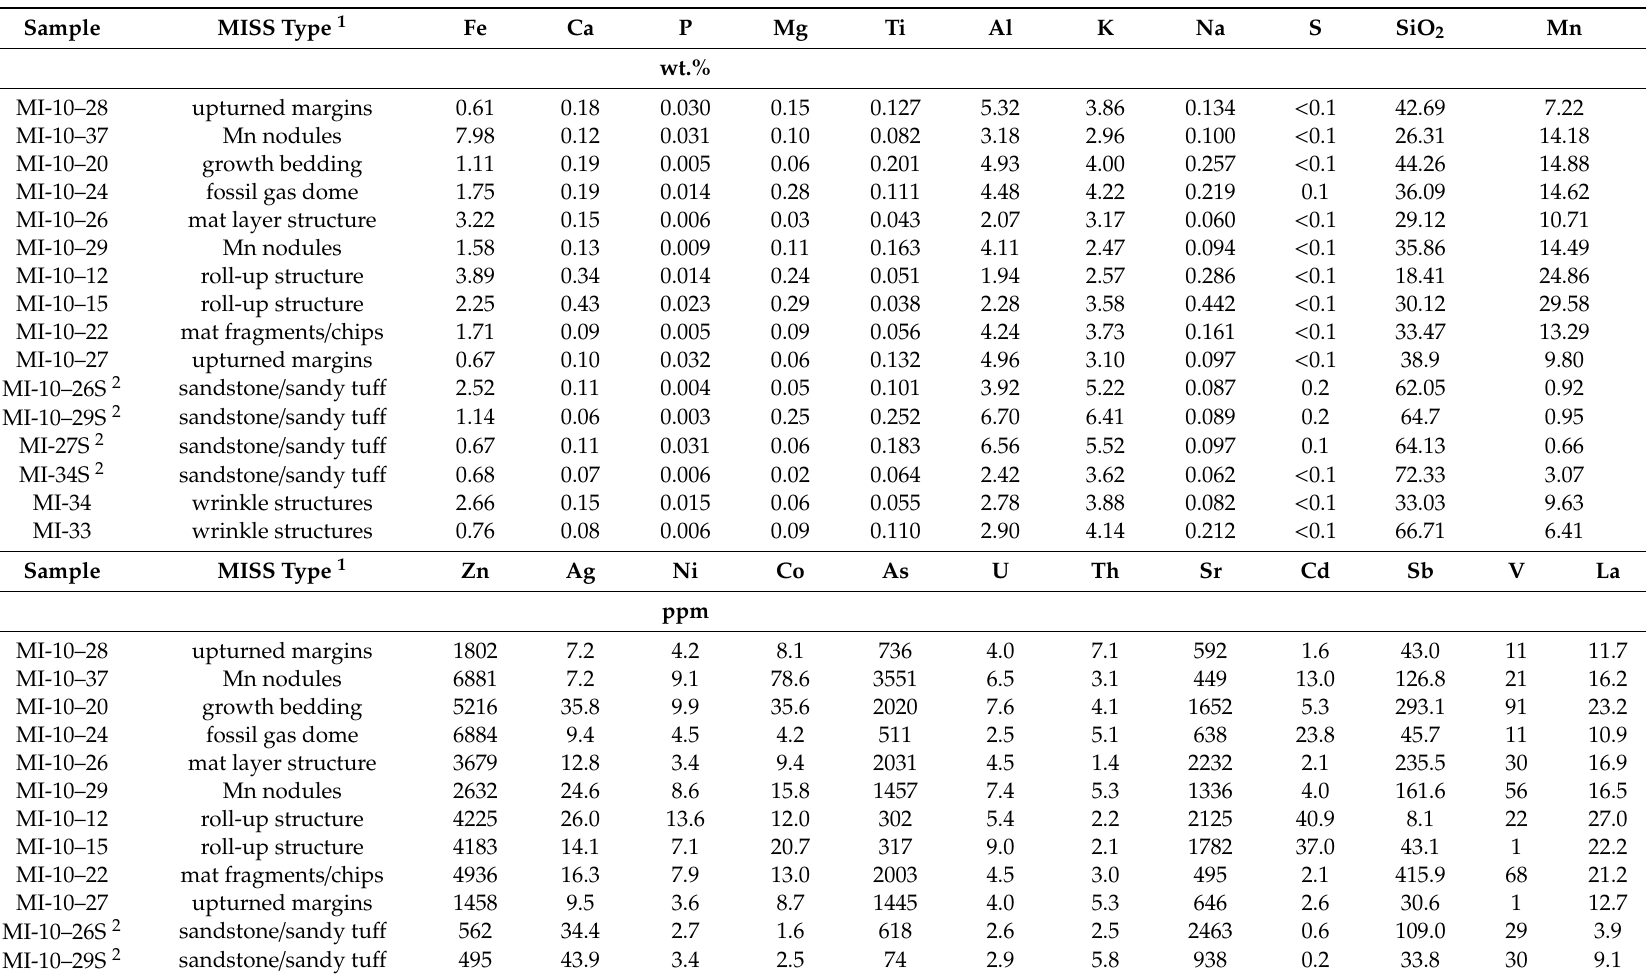
Table 1. Whole-rock chemical analyses of selected major and trace elements in di ff erent Mn-mineralized microbially induced sedimentary structures (MnMISS).